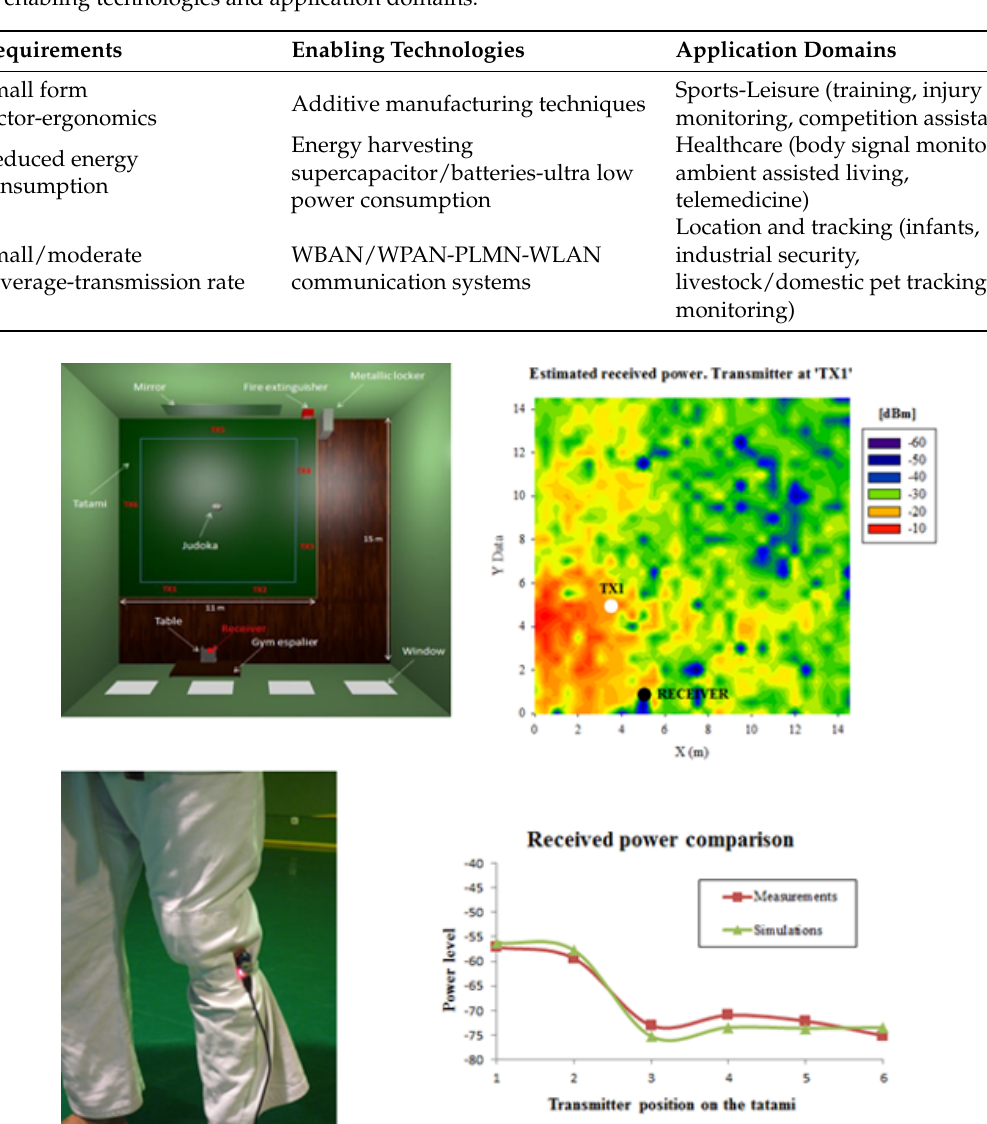
Figure 5. Wearable node integration for judo training/monitoring applications. Device integration has been analyzed in terms of human body impact on node performance in order to optimize the network layout as well as the integration of the device as described in Reference